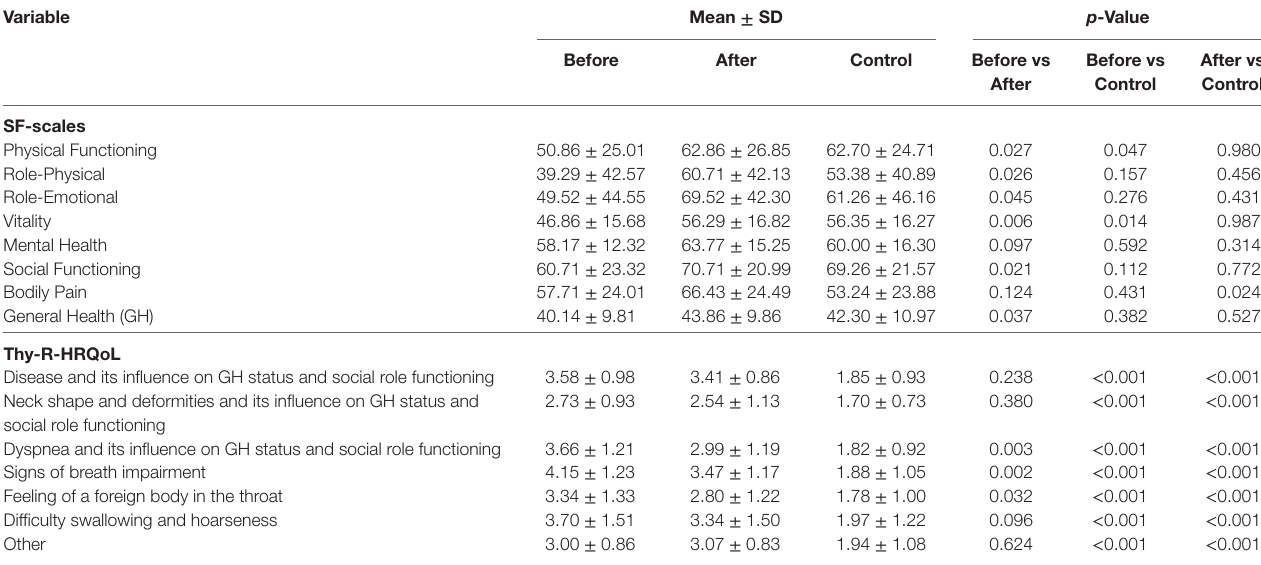
TaBle 1 | 36-item Short Form (SF-36) and Thyroid-Related Health-Related Quality of Life (Thy-R-HRQoL) scores results before, after 131-I treatment, and in the control group and statistical significance of changes. Variable Mean ± sD p -Value